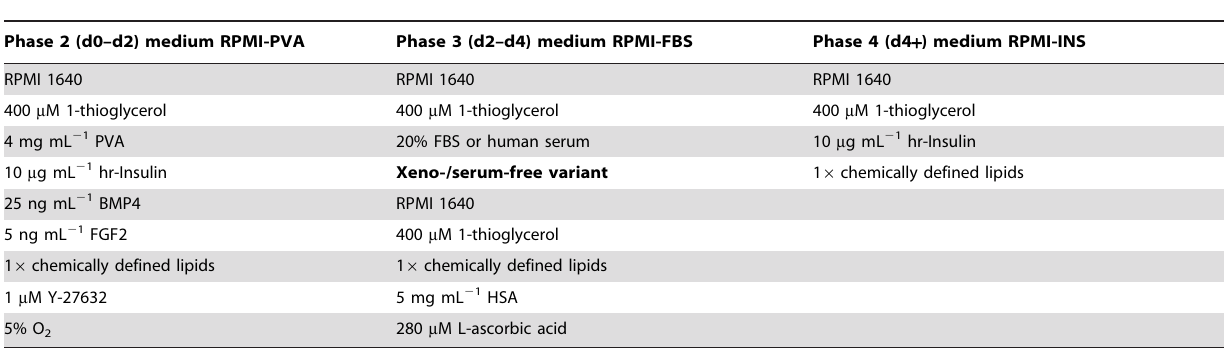
Figure 3. Controlled growth of hPSC lines for reproducible cardiac differentiation. ( A ) Schematic of monolayer hESC/hiPSC culture technique. This monolayer technique uses conditioned medium prepared in a defined manner, single-cell passaging, automated cell counting, plating cells at a known density, and passaging every three days. ( B ) Stable growth rates of H9 hESC, viral fetal fibroblast-derived hiPSC lines iPS(IMR90)-1 and iPS(IMR90)-4, non-viral CD34 + cord blood-derived hiPSC lines CBiPSC6.2, CBiPSC6.11, and non-viral adult fibroblast-derived hiPSC line iPSCWT4. ( C ) The homogenous culture phenotype seen when culturing H9 hESC as feeder-free monolayers (left), compared in comparison to typical colony morphology of cells grown in co-culture with MEF (right). ( D ) Comparable SSEA4 and TRA-1-60 expression of H9 hESC growing as monolayer cultures (left) or colonies grown in co-culture with MEF (right). doi:10.1371/journal.pone.0018293.g003 described as RPMI + PVA (Table 1). The combination of the Other growth factors including NODAL, activin A, TDGF1, growth factors BMP4 and FGF2 was determined to be necessary BMP2, BMP6, TGFB, IGF1, IGF2 and WNT3A were each for optimally efficient cardiac differentiation (Figure S4A, B). individually titrated between 1–100 ng mL 2 1 , and none were Table 1. Final optimized media formulations for each of the three steps of cardiac